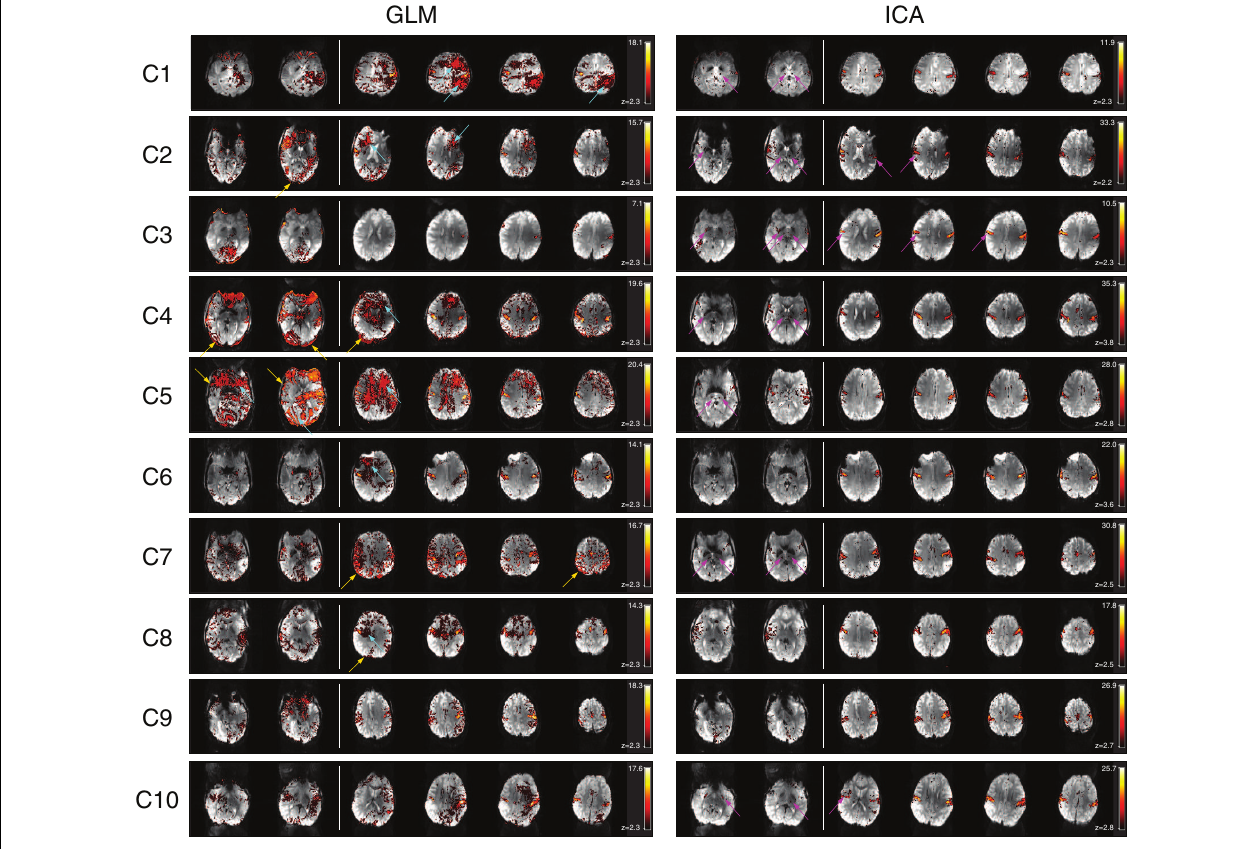
FIGURE 2 |A comparison of GLM and ICA analyses of 7T fMRI data with a chin task . GLM results are contaminated by motion artifacts (yellow and cyan arrows). ICA components show no motion contamination and bilateral activation throughout primary motor areas. Activated areas not present in